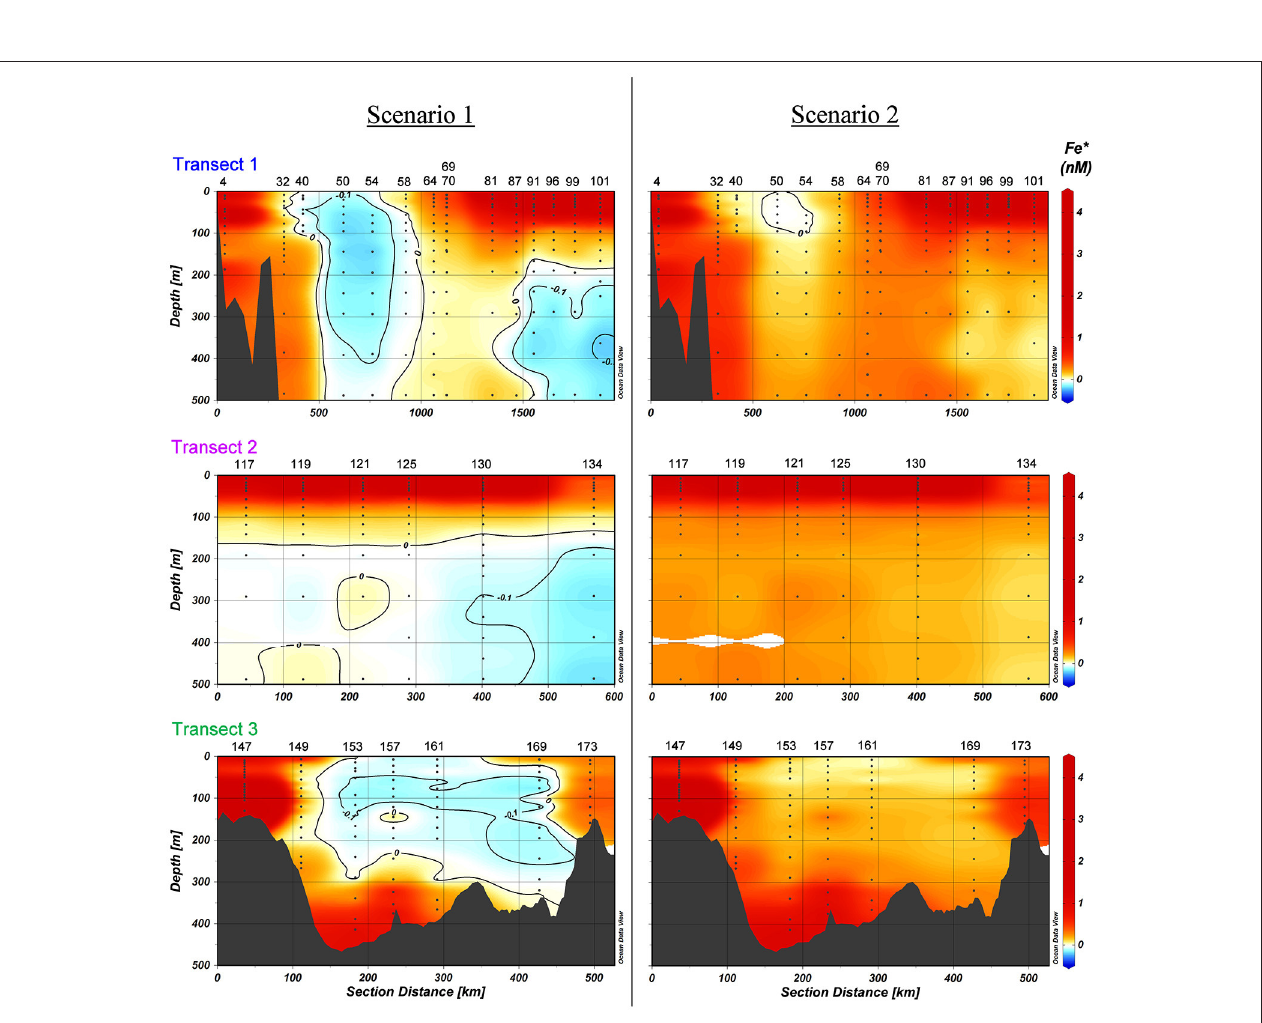
Frontiers in Marine Science |